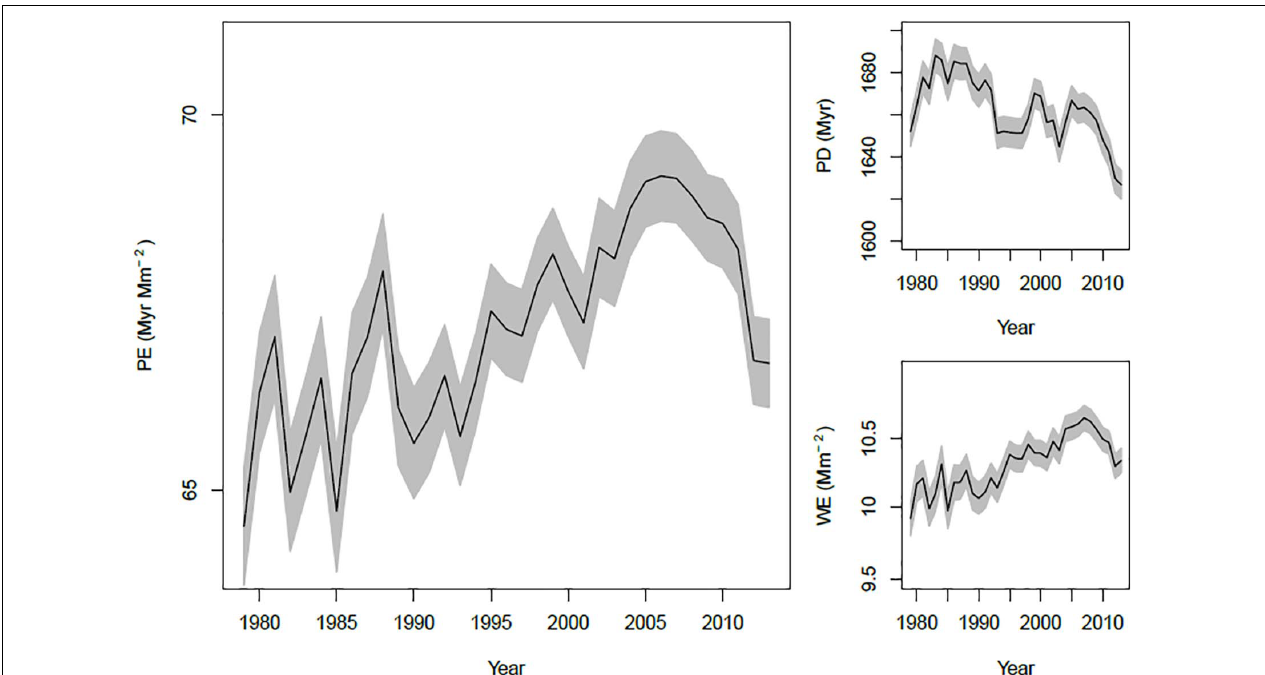
FIGURE 3 | Trends in annual mean PE, PD, and WE. Each line shows the mean of the variable across all routes measured in a year, along with its standard error (gray region).